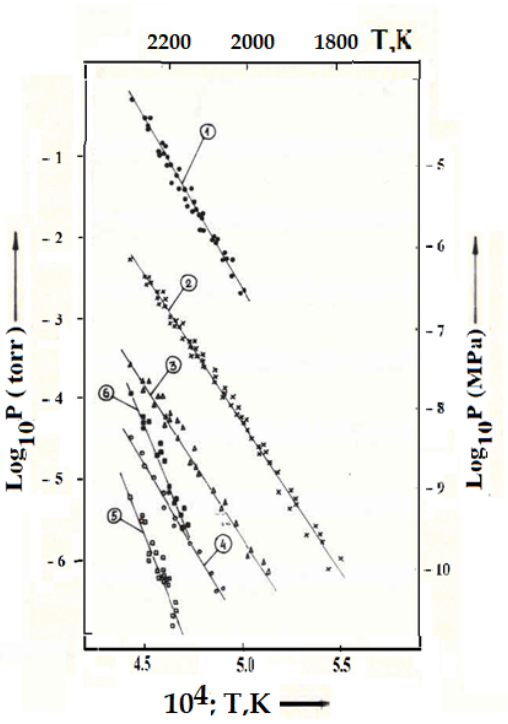
Figure 4. Dependence of partial pressures of gas phase components on temperature in Arrhenius coordinates over composition of sample 4 in Table 2 or No. 16 in Table 5: 1—nitrogen, 2—uranium, 3—uranium monoxide, 4—uranium dioxide, 5—uranium mononitride, 6—zirconium.